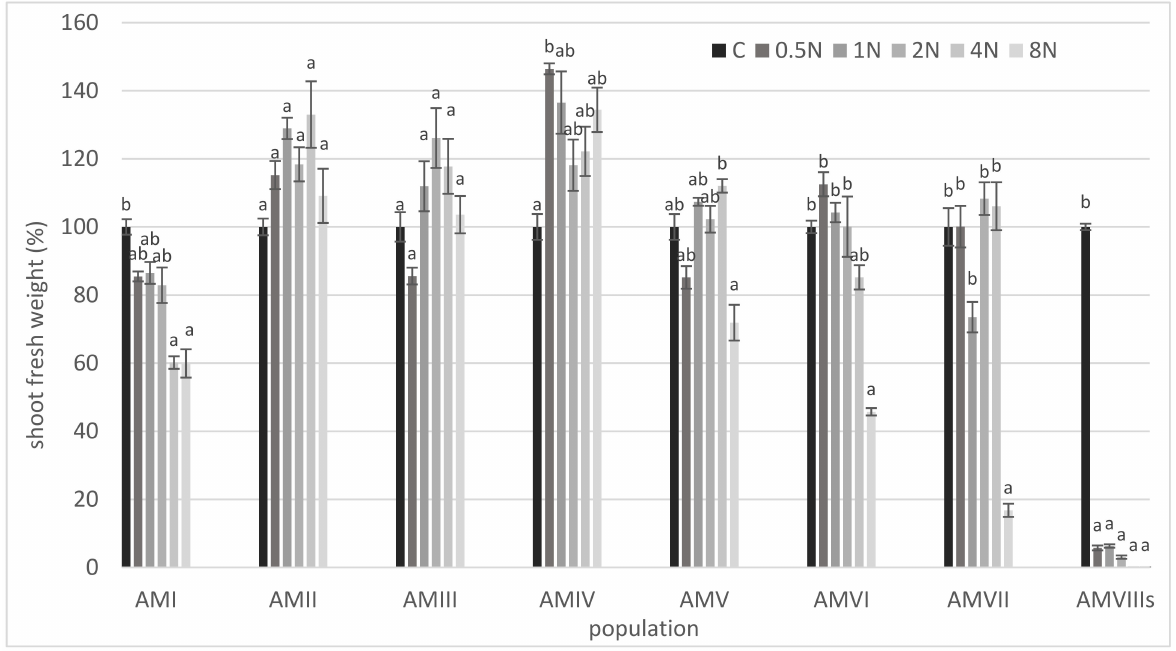
Figure 2. Shoot fresh weight of treated and untreated fenoxaprop-P-ethyl plants of A. myosuroides , expressed as a percentage of the control. The statistical analysis of the significance of differences was performed using the Tukey test for each population separately. Data are means ± SE, n = 3. Means marked by the same letter do not differ significantly. C: untreated